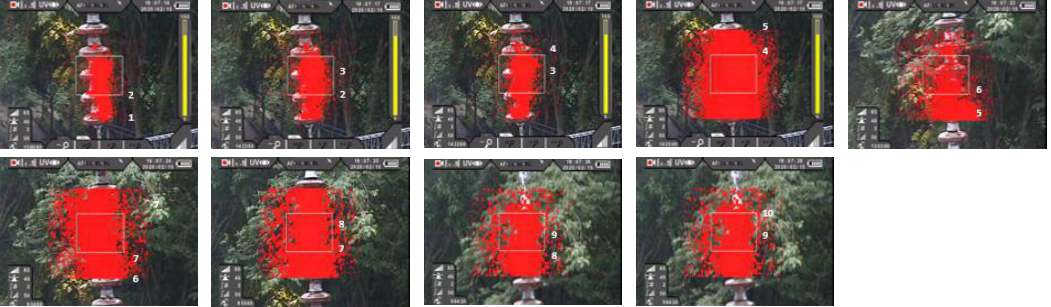
Figure 4. UV connection between the cup-and-pin insulators that had reached 100% of string length.